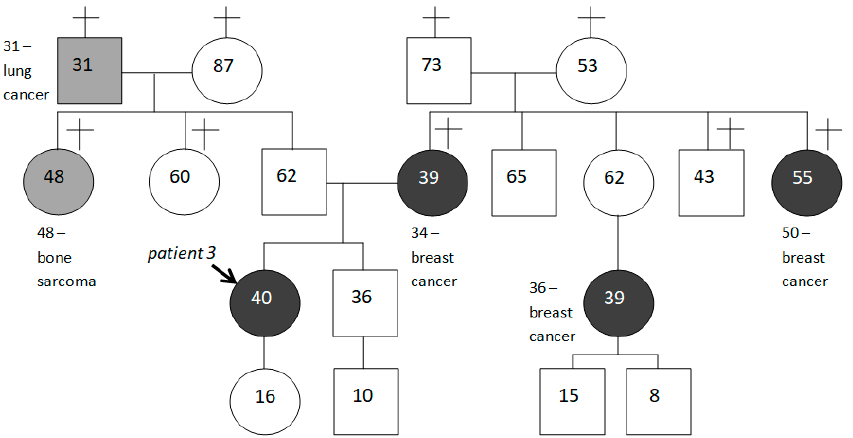
Figure 5. Family history of patient 3, aggravated by tumors of HBOC-spectrum. Persons who developed a tumor of HBOC-spectrum are marked in dark gray; relatives with other malignancies are marked in light gray.